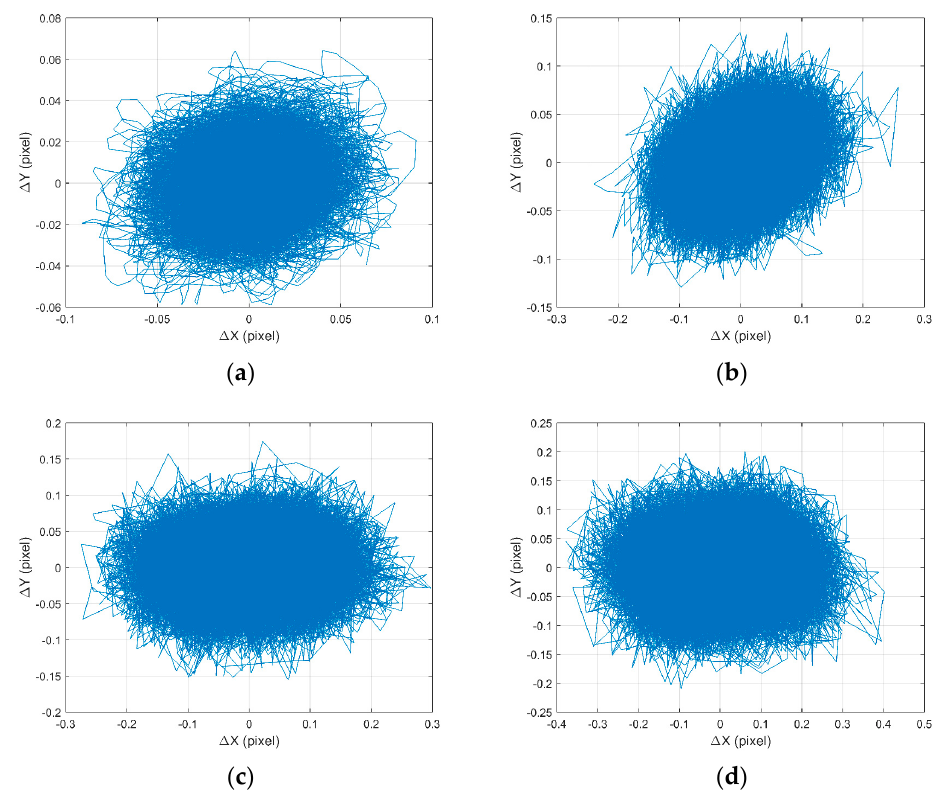
Figure 9. The image motion at each speed. ( a ) 0 rpm; ( b ) 500 rpm; ( c ) 1000 rpm; ( d ) 2000 rpm.